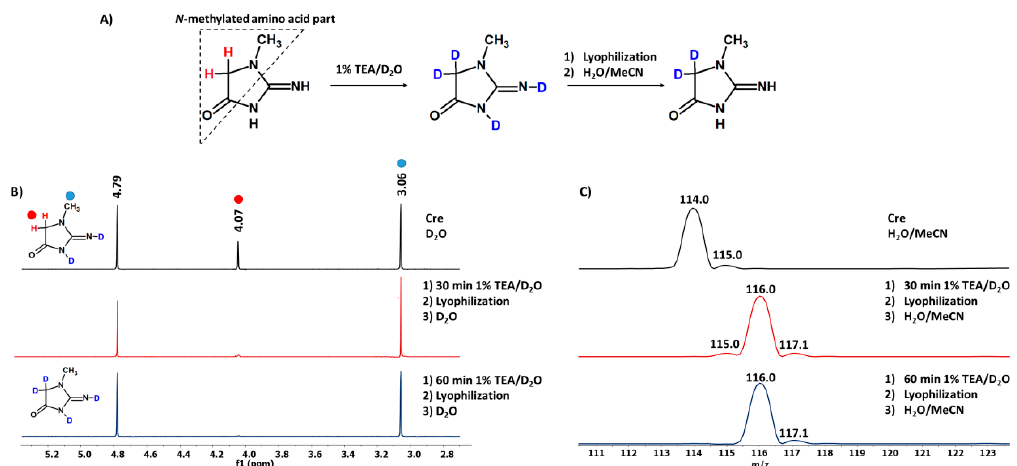
Figure 1. ( A ) Schematic presentation of the HDX reaction of α -C hydrogens within the N -methylated amino acid part in a creatinine molecule; ( B ) 1 H-NMR analysis of Cre (upper panel), and Cre after incubation in 1% TEA/D 2 O for 30 (middle panel) and 60 min (lower panel); ( C ) ESI-MS spectra in positive ion mode of Cre dissolved in an acetonitrile-water mixture (upper panel) and after incubation in 1% TEA/D 2 O for 30 (middle panel) and 60 min (lower panel), lyophilization and sample redissolving in an acetonitrile-water mixture.